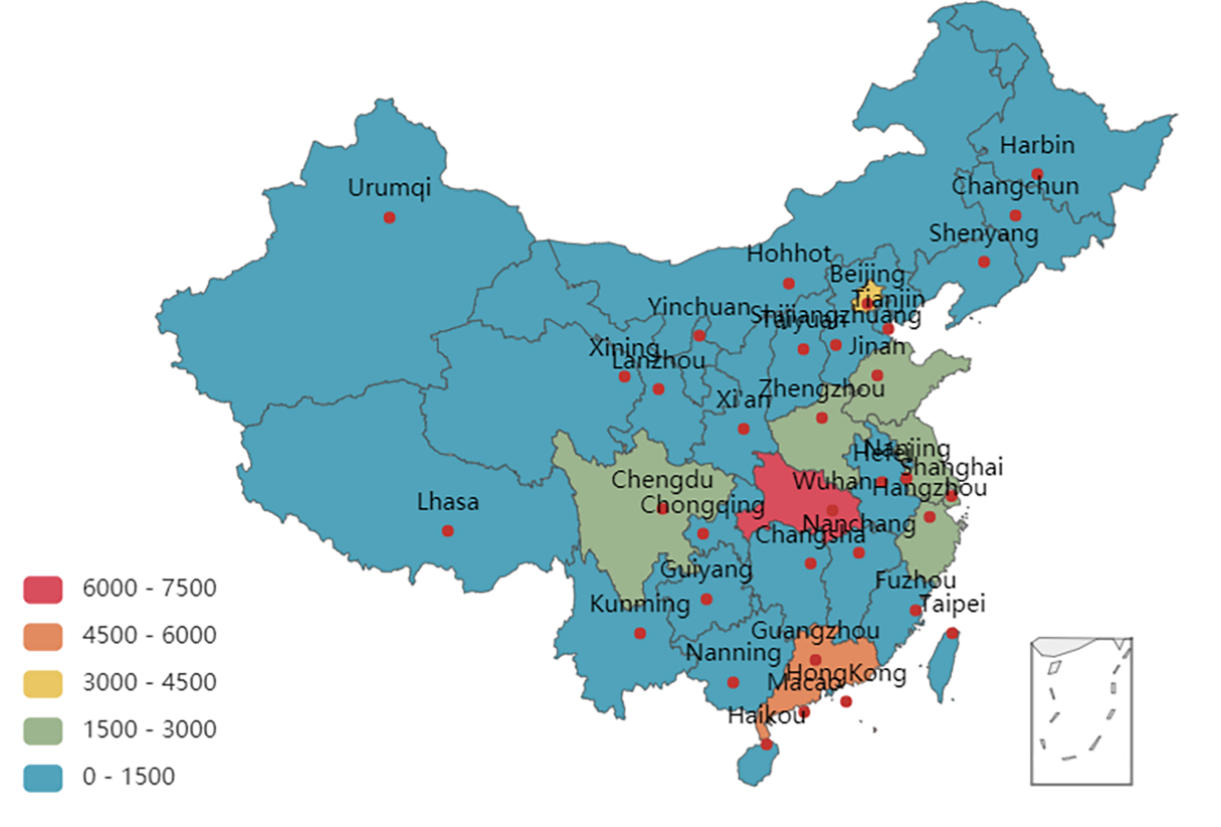
Figure 3. Spatial distribution of comments from Sina Weibo users